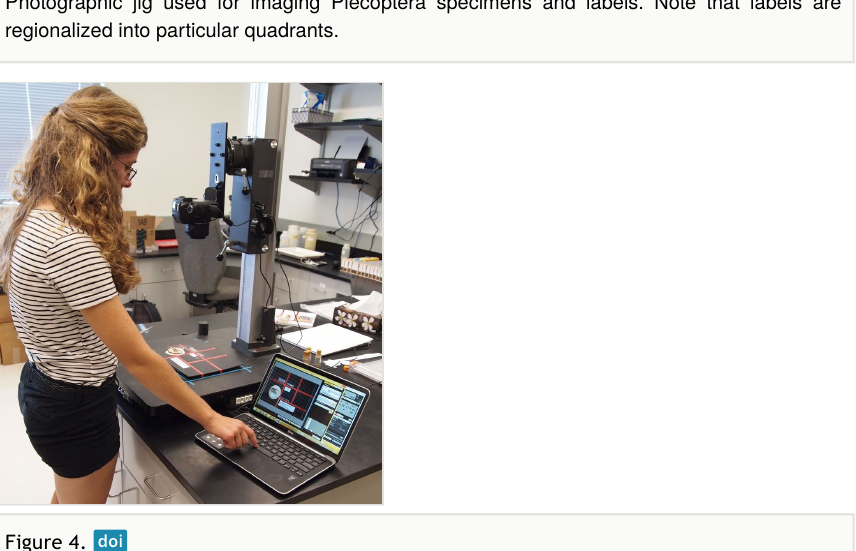
Camera, stand, and computer setup used for imaging Plecoptera specimens and